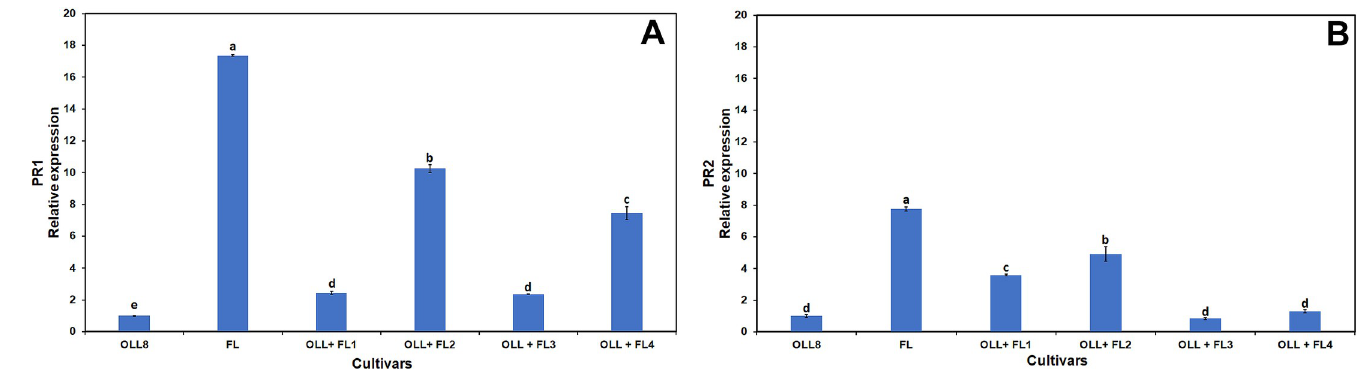
Fig 6. Relative expression of PR1 (A) and PR2 (B) transcripts in OLL8, finger lime (FL) and four selected OLL8+FL allotetraploids. Bars represent means ± standard error. Means separation by Tukey’s honestly significant difference test (P � 0.05).